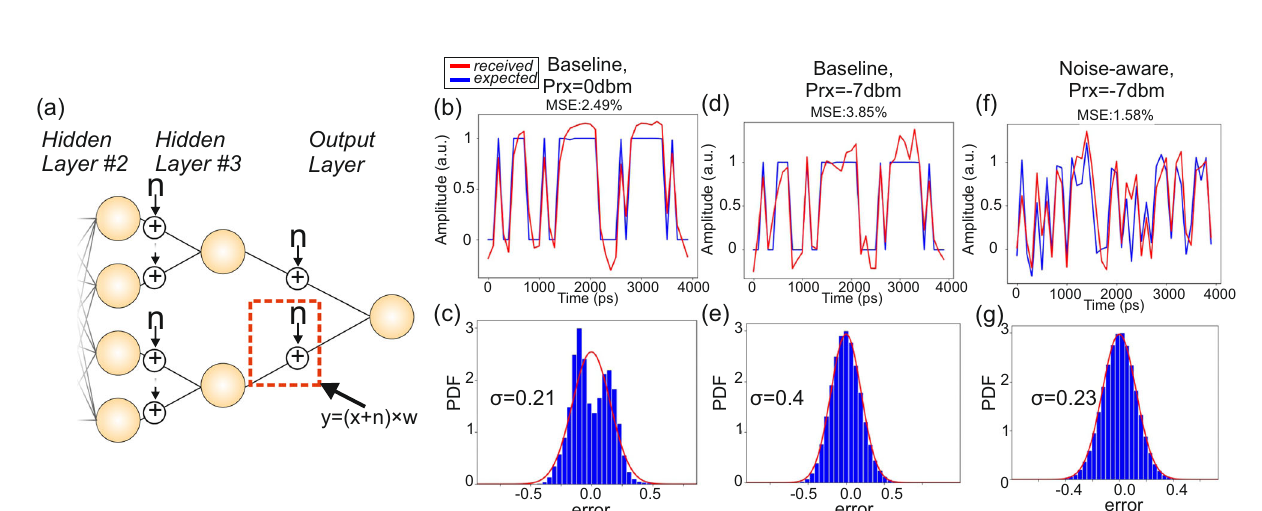
Fig. 3 | Experimental results for MNIST classi fi cation. a – g Time traces from the experimental evaluation of MNIST classi fi cation task on CPNN architecture illus- trating the expected and the received signals, h – j noise distribution bar charts of